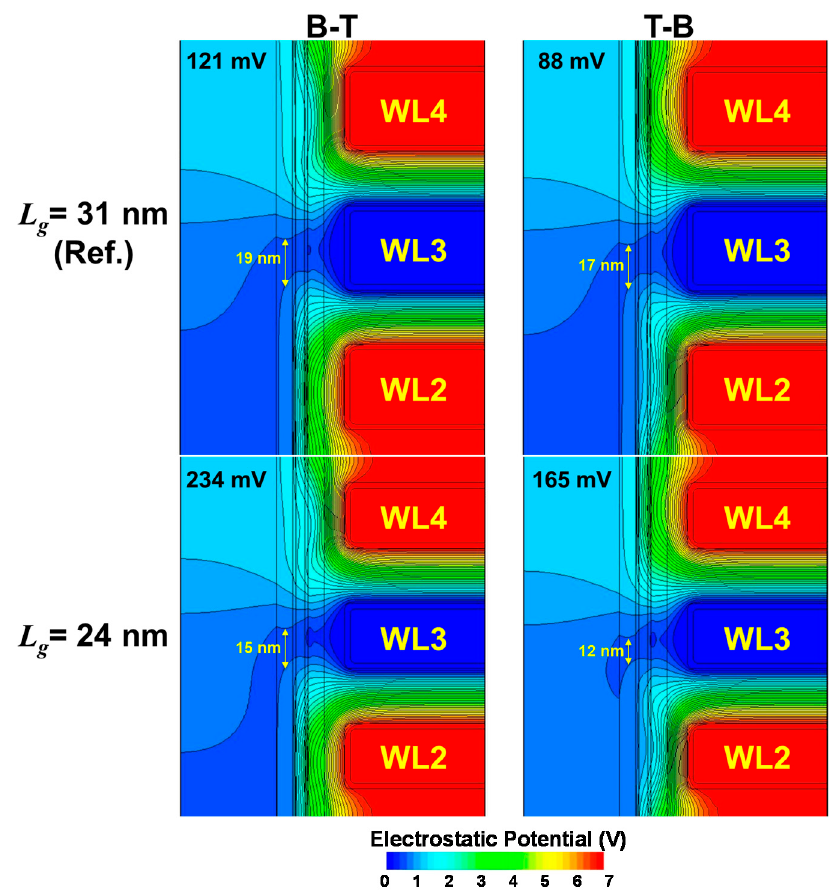
Figure 6. Electrostatic potential distribution change with L g scaling (31 → 24 nm) Both are after EP7 interference ( V t,Victim = − 0.99 V, V t,Aggressor = 3.2 V) followed by reading at the moment at V WL3 = − 1 V.